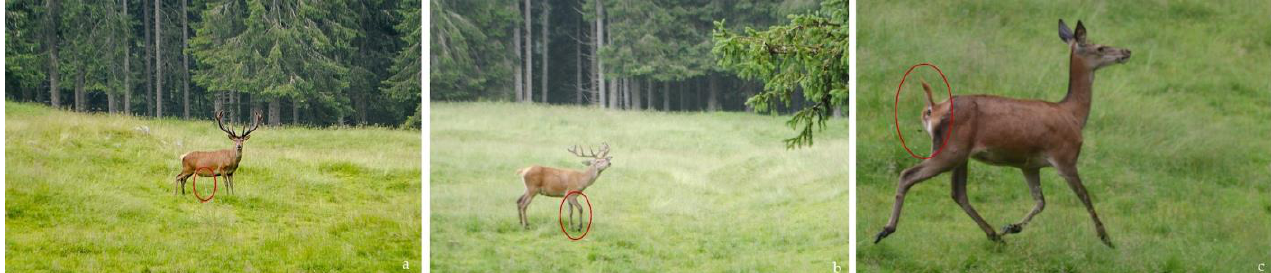
Figure 5. Three different alarm signals. ( a ) The urination before flight displayed by the dominant male. ( b ) The stomping of the hoof on the ground performed by a subordinate male. ( c ) The defecation during flight performed by a female without a fawn.